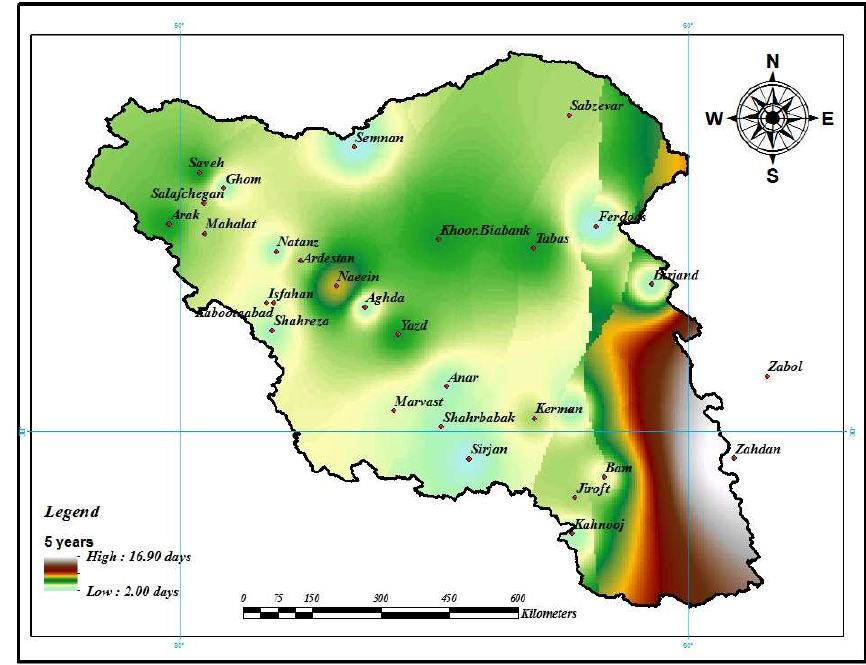
Figure 12. Dust day duration with a 5-year return period in the study area.